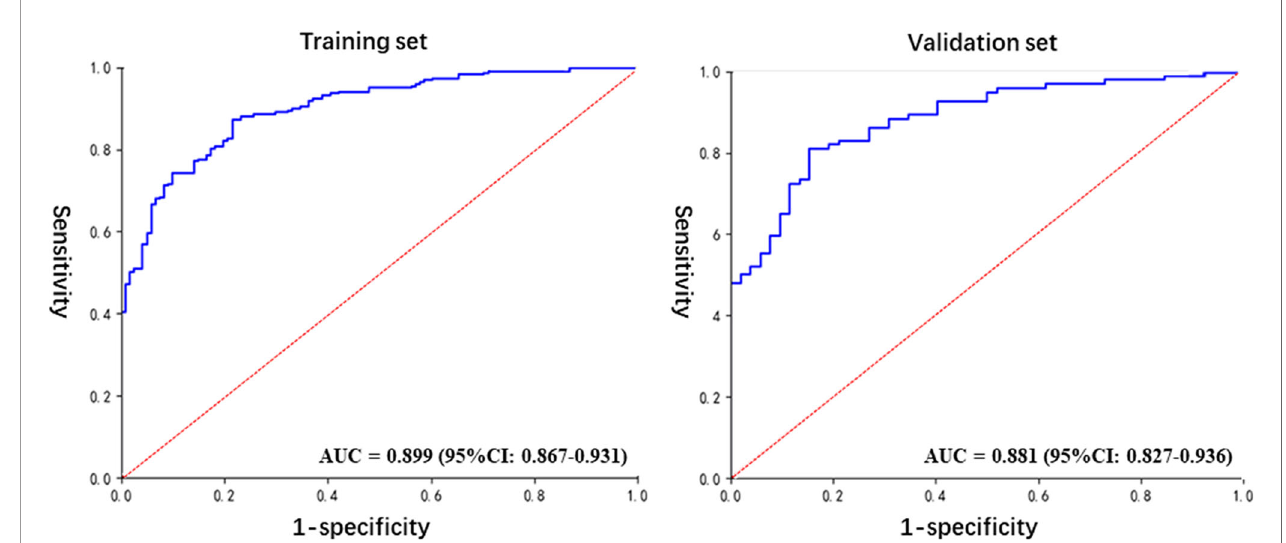
FIGURE 4 | The ROC curves for the diagnosis of the radiomics model in the training and validation